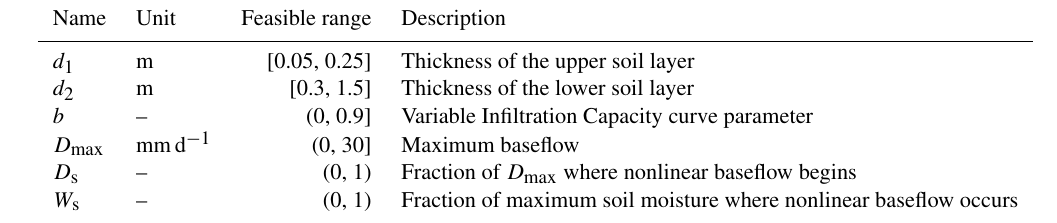
Table 1. Main parameters controlling the rainfall–runoff process in VIC. The third column contains the range of each parameter value considered during the calibration process. Note that these are the same ranges typically adopted for the implementation of VIC to large basins (cf., Dan et al., 2012; Xue et al., 2015; Wi et al., 2017).